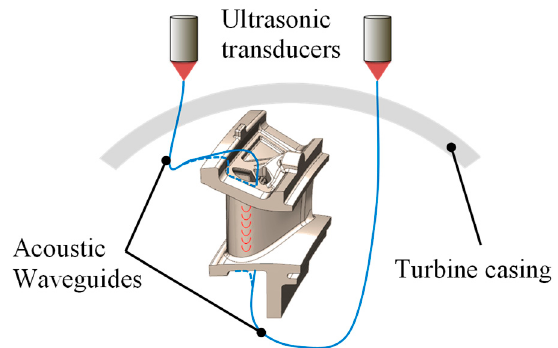
Figure 16. Schematic setup of an acoustic waveguide sensor.